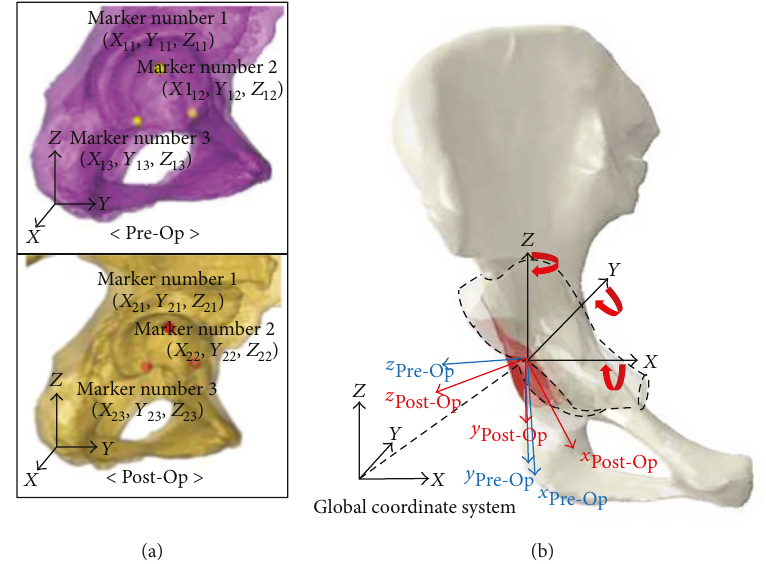
Figure 2: Reconstructed solid models of the pelvis based on the Pre- and Post-OP CT scans. The extent of osteotomy of the acetabulum was shown with a dotted line. (a) Locations of the anatomic landmarks in Pre- and Post-OP models in a lateral view (mark number 1 for acetabular fossa; mark number 2, and mark number 3 for the acetabular anterior and inferior sites, resp.); (b) the global coordinate system (X, Y, and Z; sagittal, coronal, and transverse planes) were shown. Three-dimensional rotations of the acetabulum were described by three Bryant angles along each